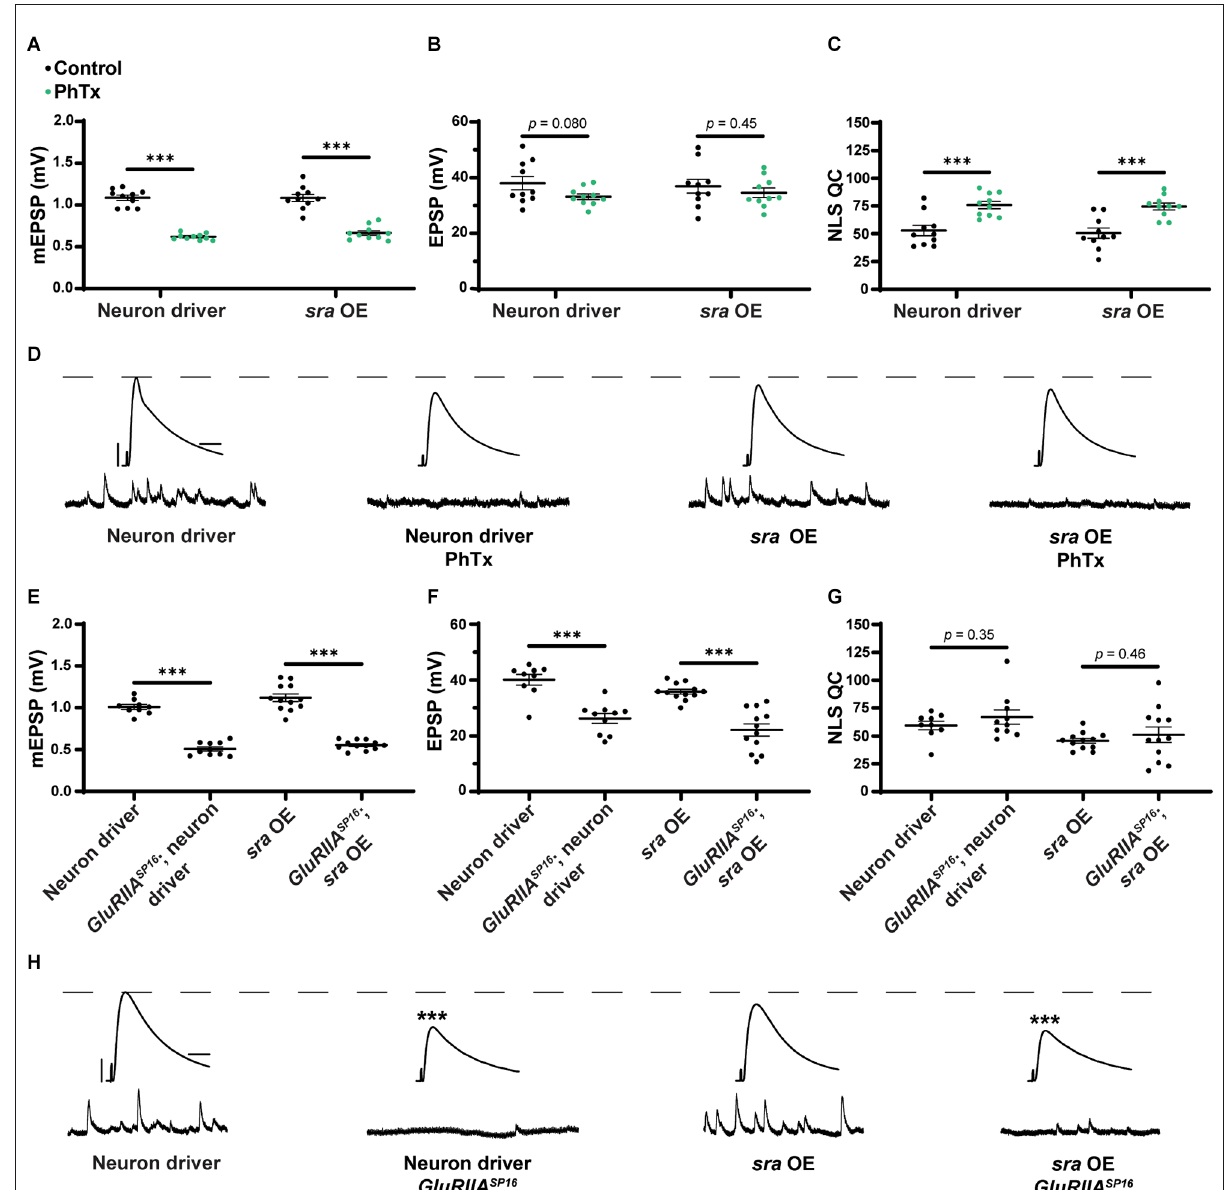
FIGURE8 Maintenance of presynaptic homeostatic potentiation is impaired by neuronal overexpression of sra but acute expression is not. (A–C) Quantification showing average mEPSP amplitude, EPSP amplitude, and NLS quantal content in pre-GAL4 control and pre-GAL4 driven sra overexpression (OE). Black points show DMSO control synapses, while green points show synapses treated with PhTx. (D,H) Representative electrophysiological traces of EPSPs (above) and mEPSPs (below). Scale bars for all traces are y = 10 mV (1 mV), x = 20 ms (500 ms) for